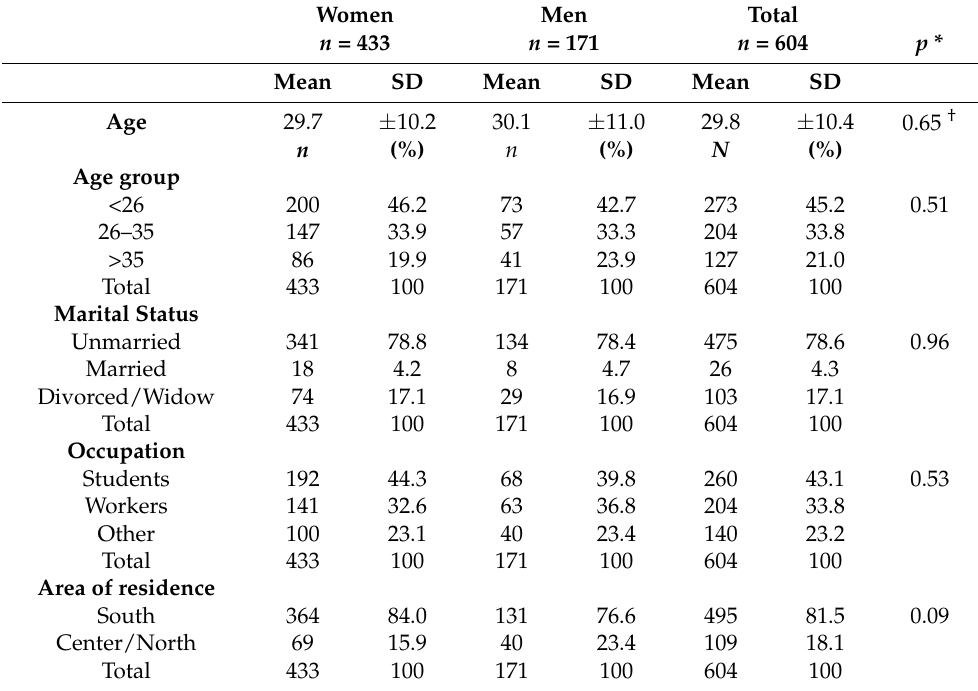
Table 1. General characteristics of the study participants in the total subjects and by